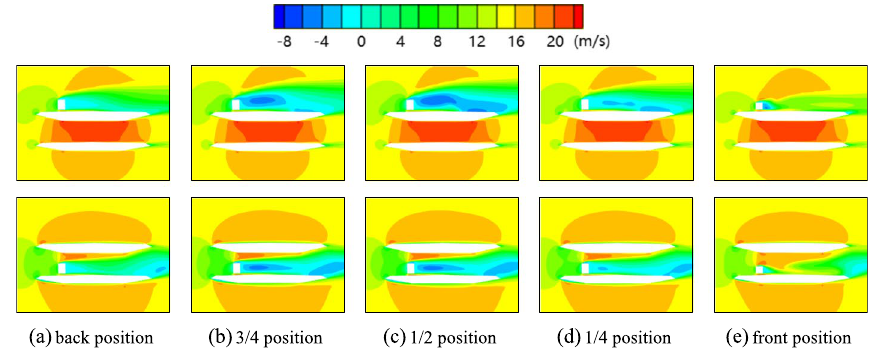
Fig. 17 Counters of the mean velocity for different cross sections (vehicle on lane 1)